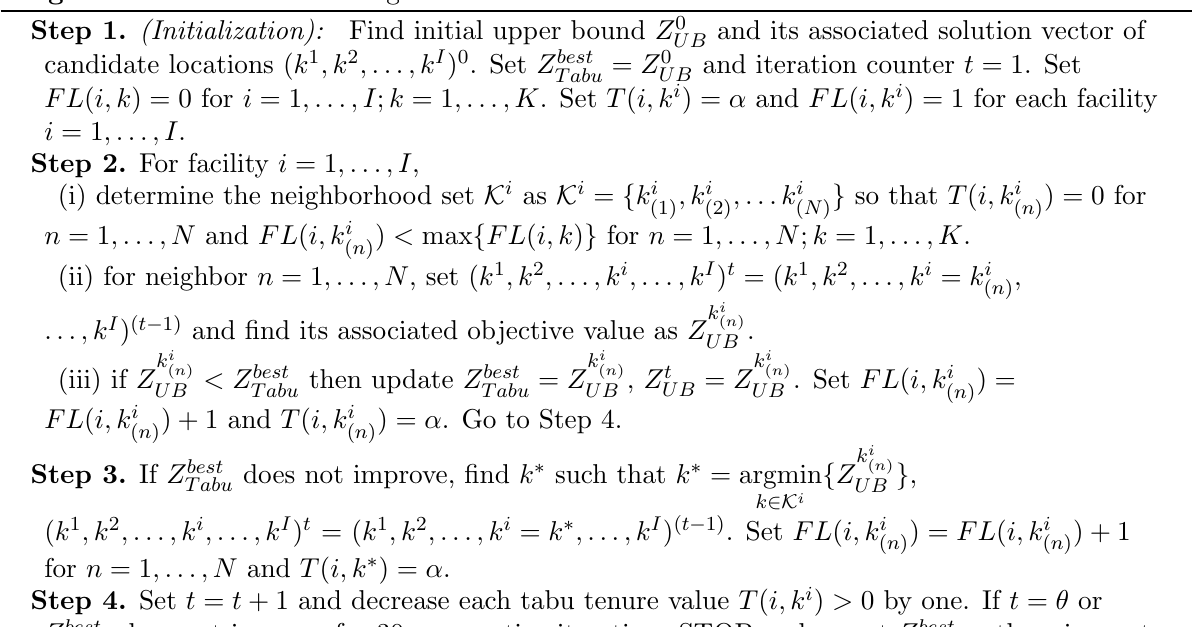
Algorithm 1: Tabu Search